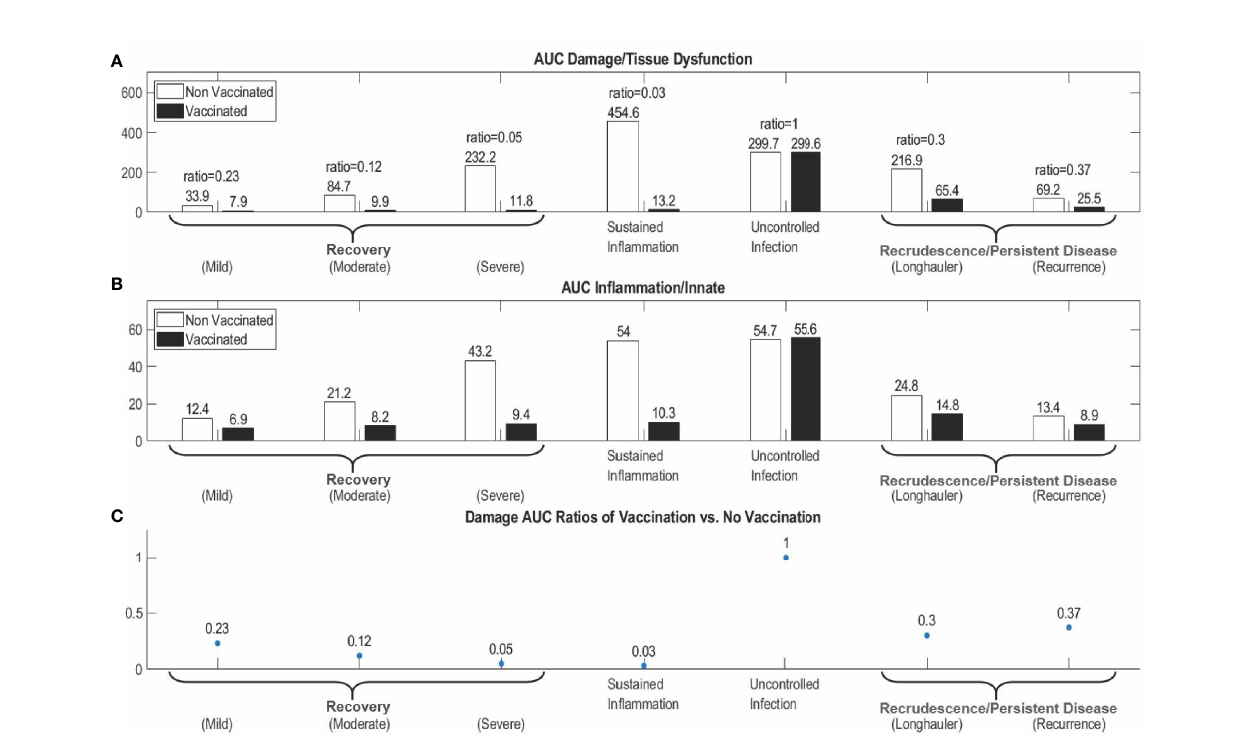
FIGURE 10 | Area under the curve (AUC) calculations for Damage/Tissue Dysfunction and In fl ammation/Innate Immunity states in order to compare results of the non-vaccination to the vaccination scenarios. AUC for the Damage/Tissue Dysfunction state, D , (Panel A ) and AUC for In fl ammation/Innate Immunity state, I , (Panel B ) in non-vaccination simulations and vaccination simulations are compared for seven scenarios spanning the four archetypes. In (Panel A ), the ratios of AUC D -Vac to AUC D -NoVac for each scenario in (Panel A ) are displayed above the respective pair of bar graphs and quantify the relative effectiveness over all the scenarios of the vaccination in reducing overall damage. These ratios are also graphed in (Panel C ) Ratios < 1 show effectiveness of vaccination for reducing overall AUC in a scenario, whereas Ratios ≥ 1 indicate that vaccination was not helpful and potentially harmful. For the non-vaccination simulations, AUC is calculated over 160 days post infection, whereas the vaccination simulation AUCs are calculated from the time of the fi rst vaccination dosage plus 160 days post infection, 160 + 42 days, to account for damage created from the adjuvant-inducing I response during the vaccination